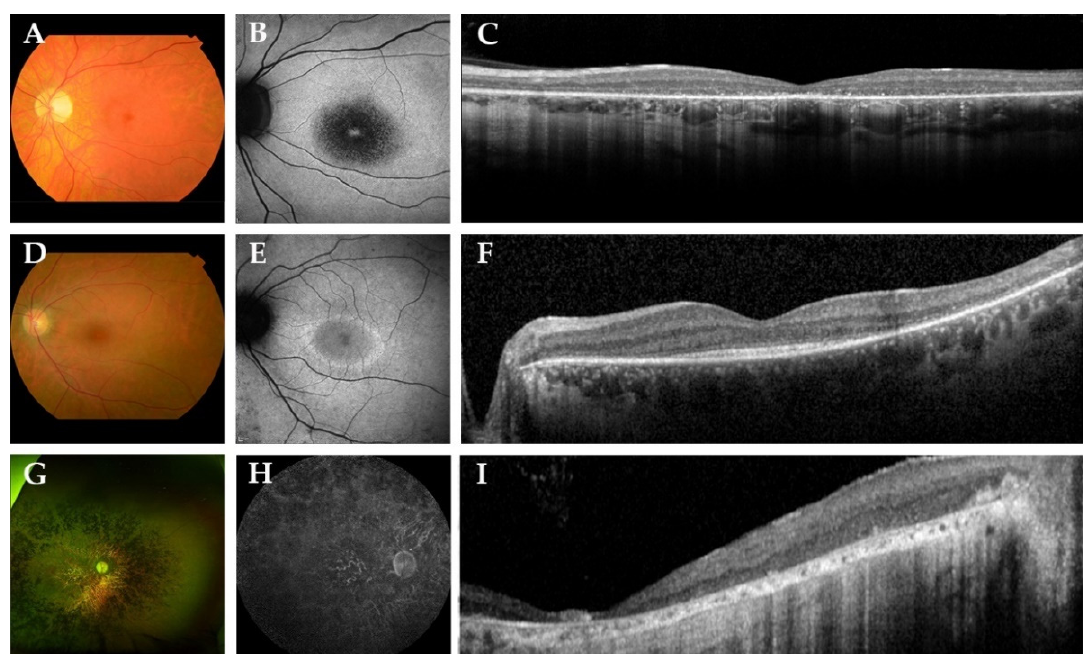
Figure 2. Representative color fundus photographs with corresponding fundus autofluorescence (FAF) and spectral-domain optical coherence tomography (SD-OCT) images in this cohort of patients with biallelic ABHD12 variants. ( A – C ) The left eye of patient D-6, a 42-year-old man with Snellen best-corrected visual acuity (BCVA) of 20/400. Fundus photography revealed a slightly pale optic disc, atrophic macular changes and retinal pigment epithelium (RPE) changes in the midperipheral retina, in the absence of spicular hyperpigmentation. FAF imaging showed a region of hypo-autofluorescence (hypo-AF) in the central macula with a hyper-autofluorescent (hyper-AF) spot in the fovea. On SD-OCT, loss of the external limiting membrane and ellipsoid zone was observed. ( D – F ) The left eye of a 36-year-old woman, patient E-7, with Snellen BCVA of 20/29. Fundus imaging showed macular and midperipheral alterations, with no evident spicular hyperpigmentation. On FAF imaging, hypo-AF zones of RPE degeneration were present outside the macula and a macular hyper-AF ring was observed. SD-OCT showed preservation of the outer retinal layers in the (para)fovea. ( G – I ) Patient F-8, a 53-year- old man with light perception visual acuity, showed extensive degeneration across the entire retina with dense spicular hyperpigmentation reaching the posterior pole. FAF imaging demonstrated generalized hypo-AF due to the extensive RPE atrophy. SD-OCT showed marked chorioretinal